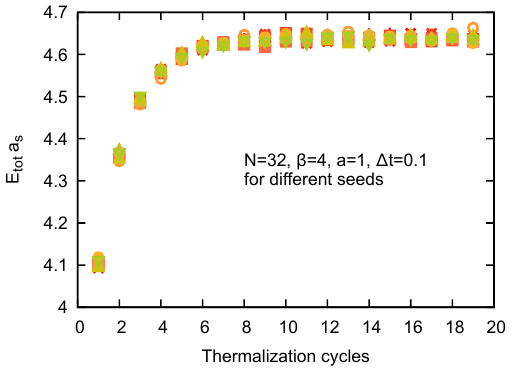
Figure 11 . Thermalization of the initial conditions in the absence of sources at β = 4 .